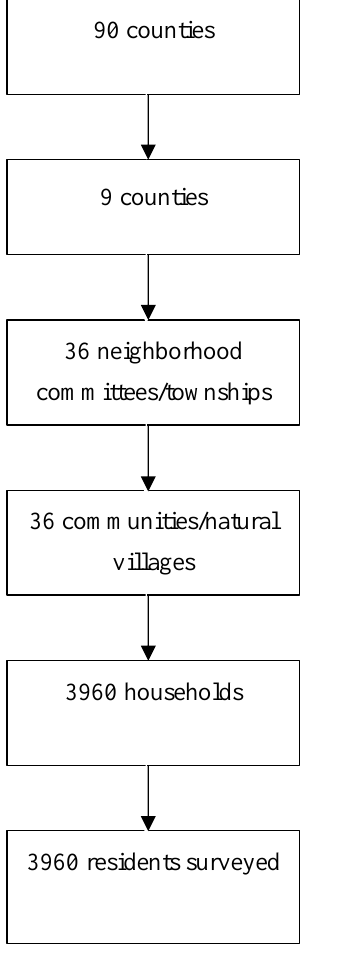
Figure 1. Flowchart of the sampling method.